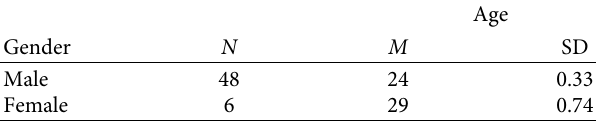
Table 2: Participants demographic